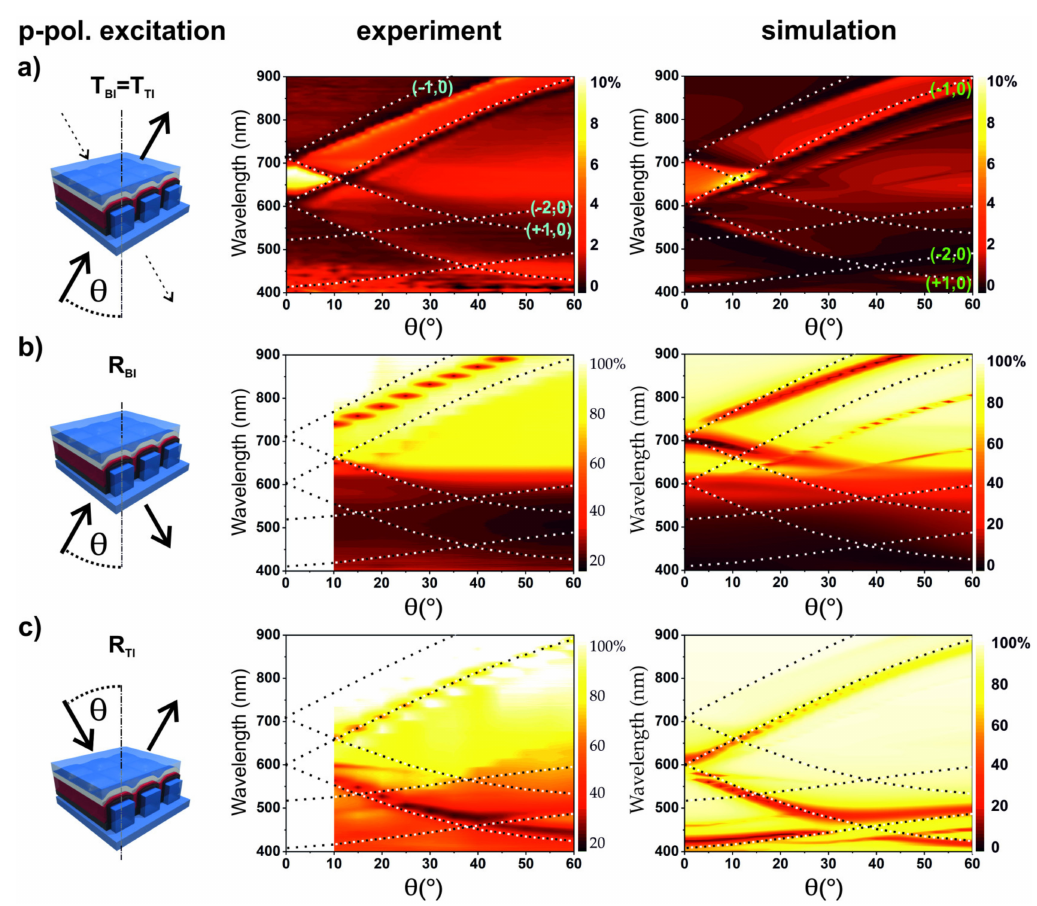
Figure 4. Schamatics (left) for side and angle resolved device characterization with p-polarized excitation (middle) and simulated spectra (right) of a half-cell device without a bottom electrode. ( a – c ) Zero-order transmission and side dependent reflection measurements. The incidence plane was set to Φ = 0 ◦ azimuthal angle for all measurements. Side dependent reflection measurement shows clear di ff erences in SPP mode excitation. Dashed lines show the analytically calculated Bragg SPP modes at metal–epoxy (green labels in the simulation results) and metal–P3HT / PCBM interfaces (light blue labels in